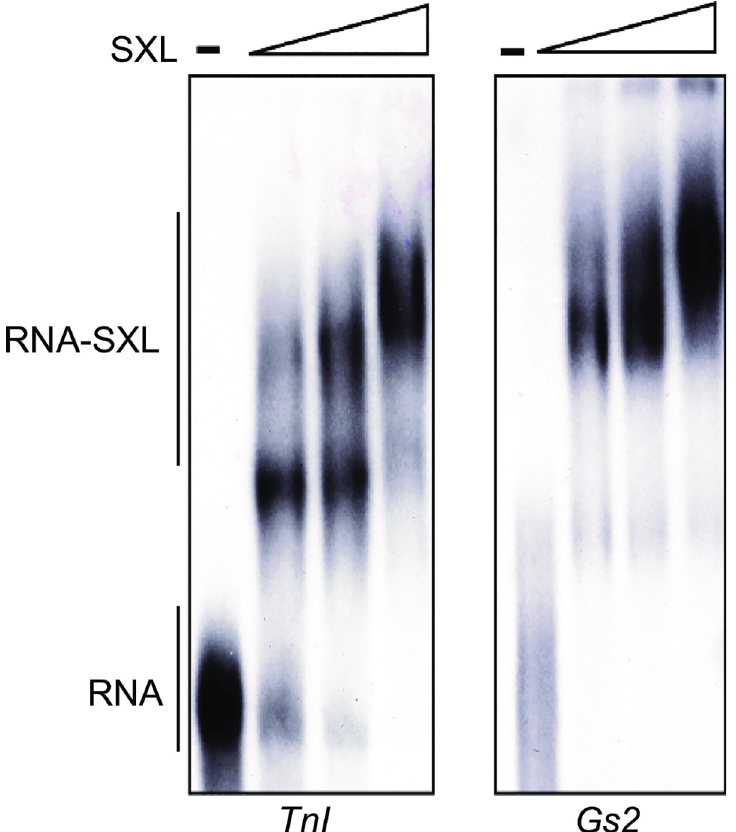
Fig 5. Binding of SXL to the specific uridine-rich sequences selected using cDNA SELEX. Electrophoretic gel mobility assay was used to determine binding affinity of SXL with the sequences identified in the 5’ UTR of the Troponin I ( TnI ) and in the 3’ UTR of the Glutamine Synthetase ( Gs2 ) transcripts. No SXL is shown by the–lane, and increasing concentrations (three-fold successive increase) of the recombinant GST-SXL protein are shown by the triangles. The–lane shows the free (unbound) RNA, and RNA-protein complexes are shown under various SXL concentrations (three-fold successive increase) (166 ng/ μ l; 55 ng/ μ l; 18 ng/ μ l). For TnI the RNA containing UUUUUUUCUUUUUUUUCU and for Gs2 the RNA containing UUUUUUUUUCUUUUUUUUGU binding sites were labeled using 32 P and gel purified before performing the binding assay.